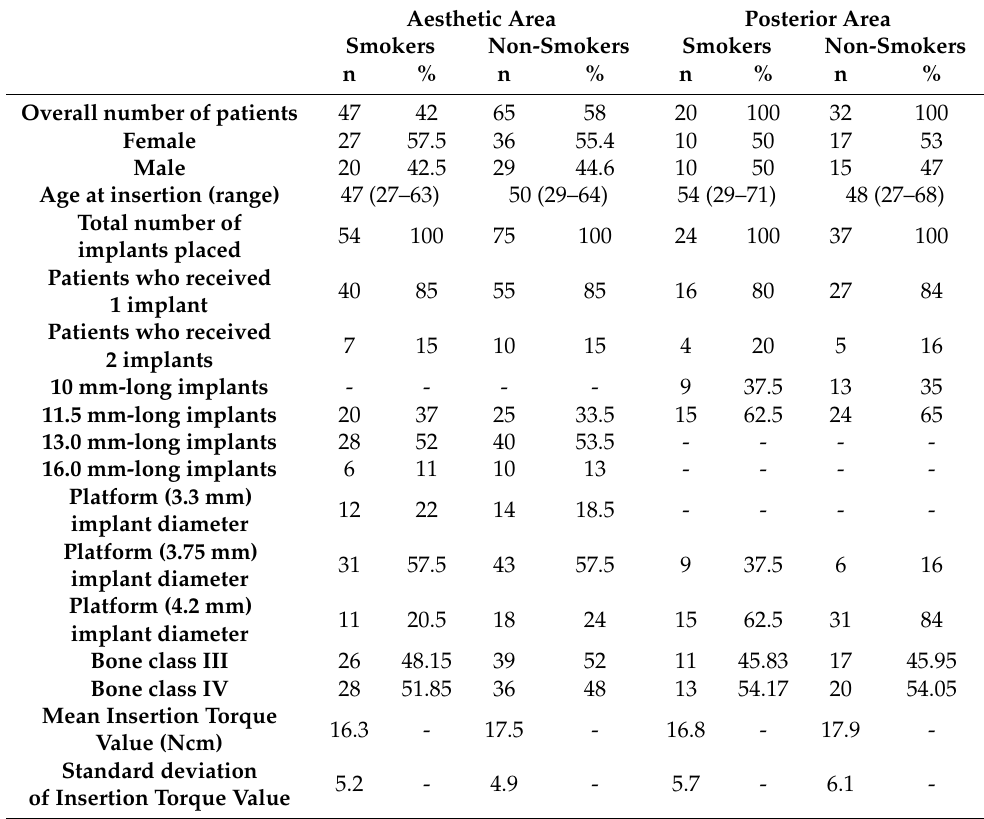
Table 1. Characteristics of Study